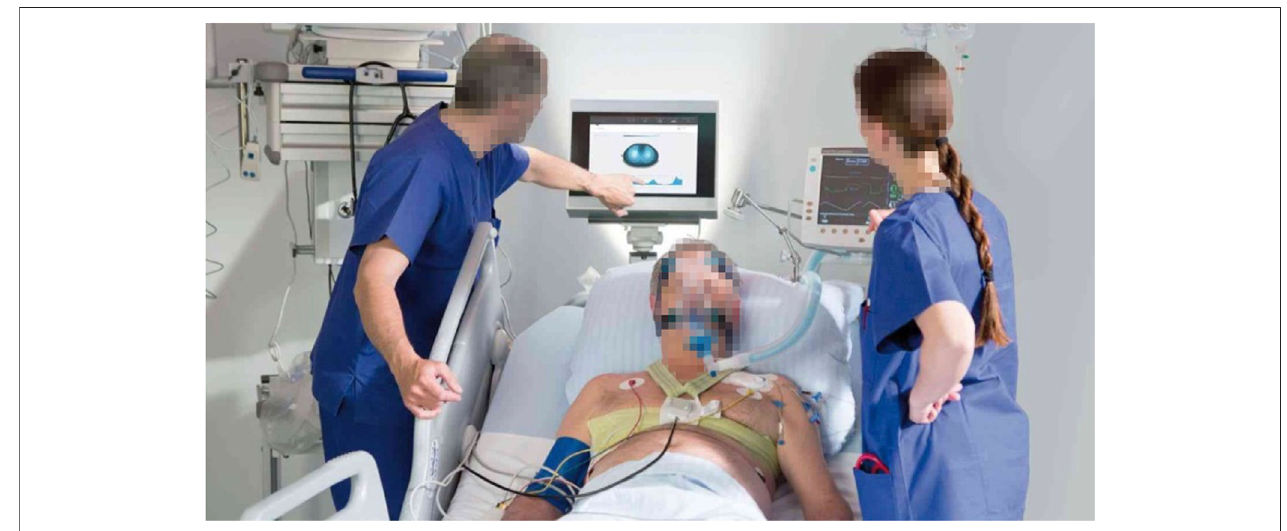
FIGURE 6 | The EIT device BB2 of Swisstom. Swisstom ’ s equipment is used in the clinical treatment of patients with acute respiratory distress.